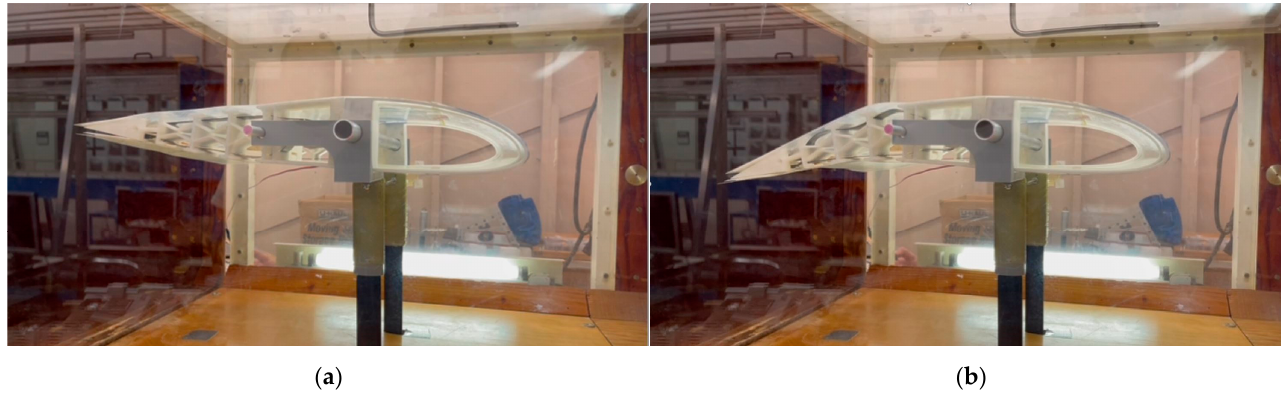
Figure 19. Two views for the assembled and camber-morphed tail stabilizer model .